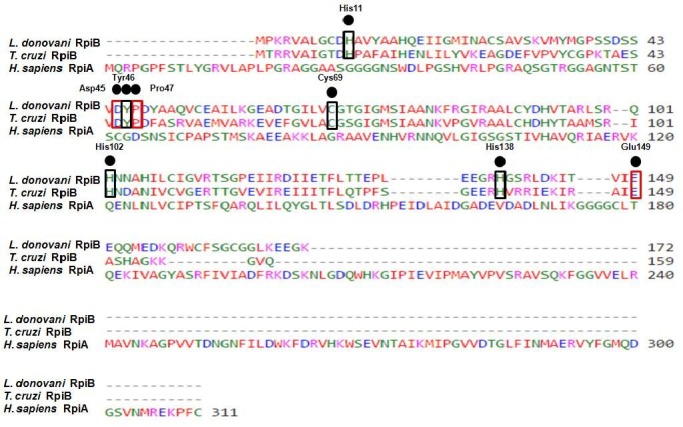
Sequence alignment of LdRpiB amino acid sequence with amino acid sequence of T. cruzi RpiB and H. sapiens RpiA using Clustal W.Black dot represents the amino acids targeted for site directed mutagenesis, black box represents the amino acids present in the substrate binding pocket of T. cruzi and red box represents the other conserved amino acids.